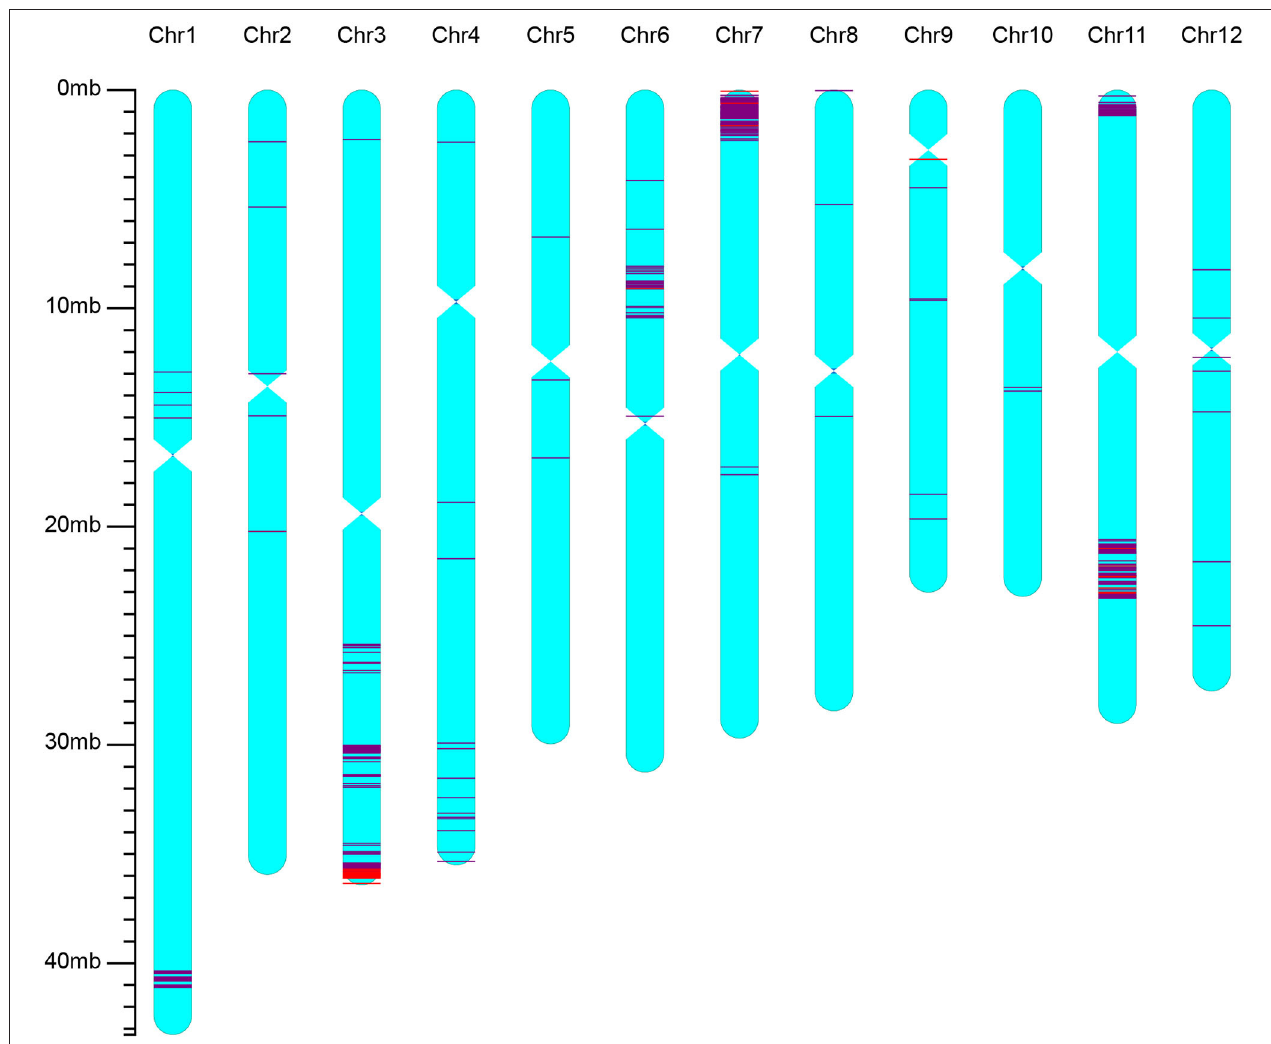
FIGURE 3 | Genetic background of the iS1000 containing genes Xa23 + Pi9 revealed by using rice 56K SNP chip. The red lines indicate the SNP loci with homozygous genotypes of the donor parent, the purple lines indicate the SNP loci with heterozygous genotypes.